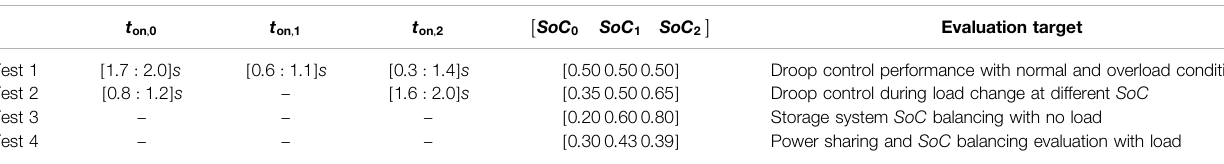
TABLE 3 | Power sharing test